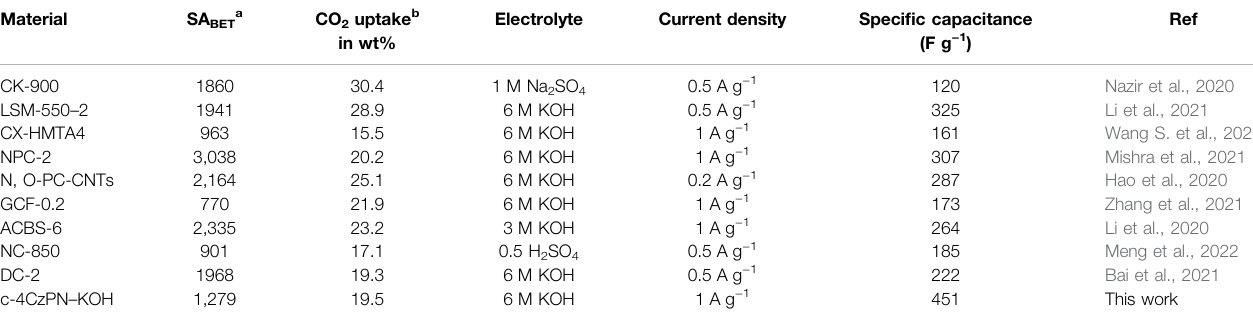
TABLE 3 | Comparison of the CO 2 uptake and electrochemical performance of the carbon materials reported in the literature.